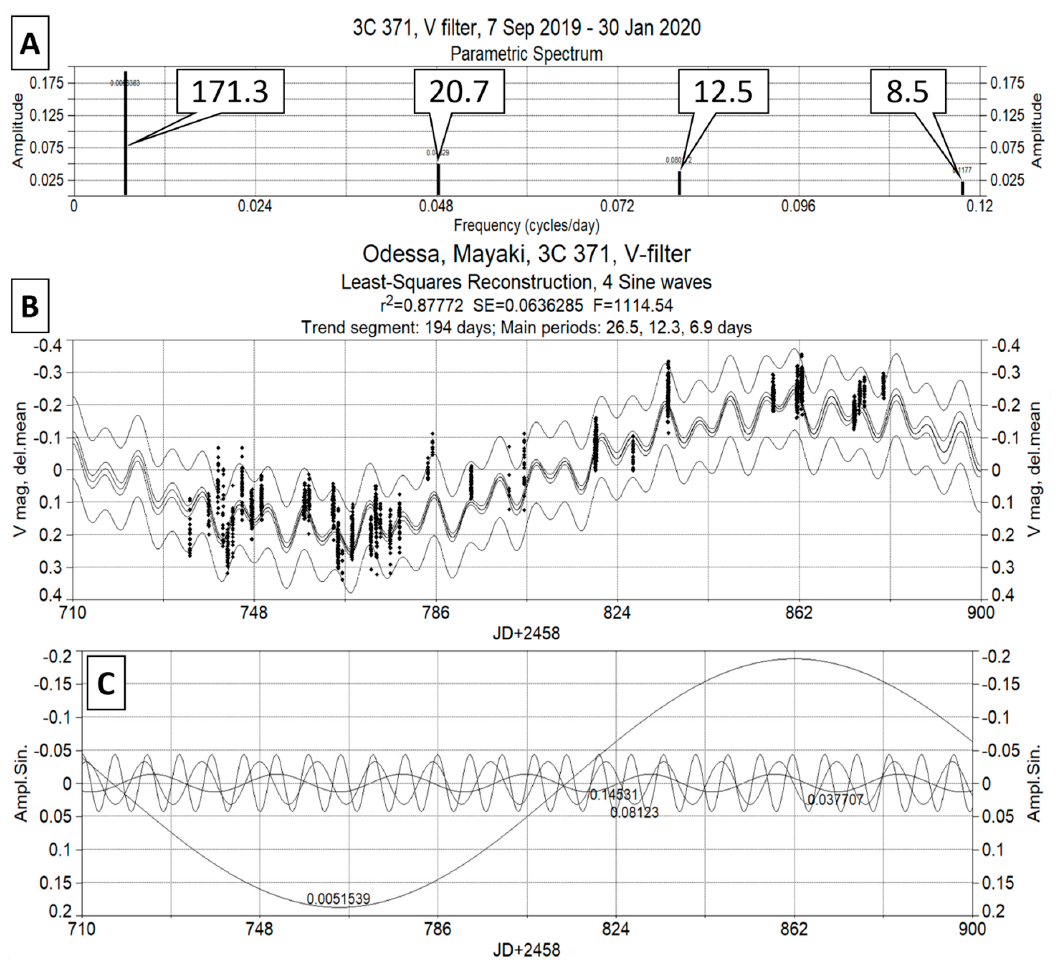
Figure 17. Result of the analysis of cyclical variability in the light curve of 3C 371 in the V filter (7 September 2019–30 January 2020), according to observations in the Mayaki observatory (Ukraine). ( A ) Parametric spectrum with periods values of 4 sinusoidal components in the time series, flags show the initial values of quasiperiods in days; ( B ) Approximation of the original observational data (the average value is subtracted), by a trigonometric polynomial from 4 sinusoids (where 1 segment of the sinusoid shows a slow trend change in brightness) that were fitted to the original data, using the least squares method, and accordingly, the values of periods for each sinusoids were refined; ( C ) This panel shows the sinusoidal components, which formed the approximating trigonometric polynomial. Thus, the following values of estimated quasiperiods were obtained: 26.5, 12.3, and 6.9 days. The estimated characteristic time of trend change in brightness of 3C 371, in this example, was about 194 days. The quasiperiod 6.9 days (very close to value 7 days, obtained earlier) was preserved in a longer series of data, which confirms the correctness of its determination.